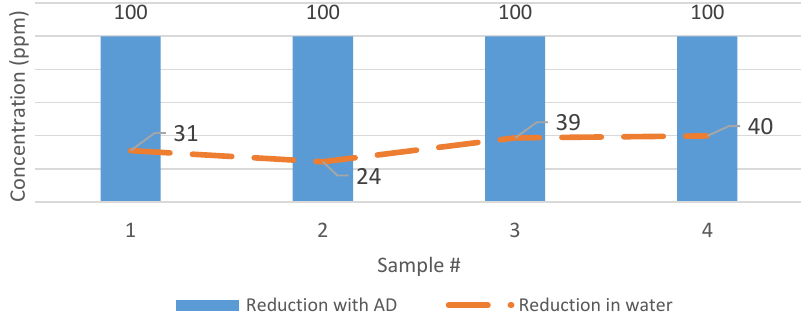
Figure 10. The removal of tylosin in water and the anaerobic digestion (AD) reactor.